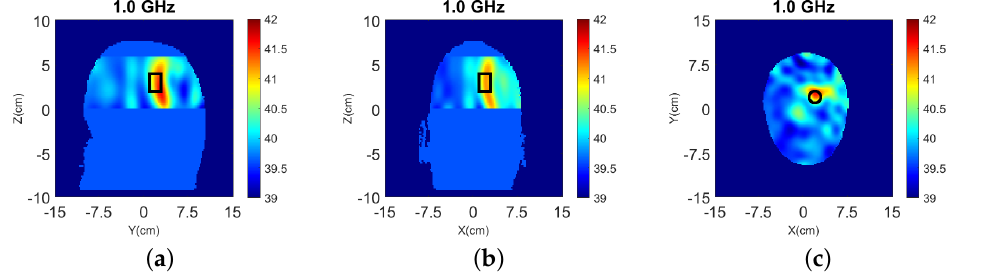
Figure 17. 3-D reconstructions of (cid:60) ( ε r ) for Case III.2 at 1.0 GHz: ( a ) y-z slice, ( b ) x-z slice, and ( c ) x-y slice. The headband of Figure 14 (with the addition of absorbing material) is used to obtain the data.